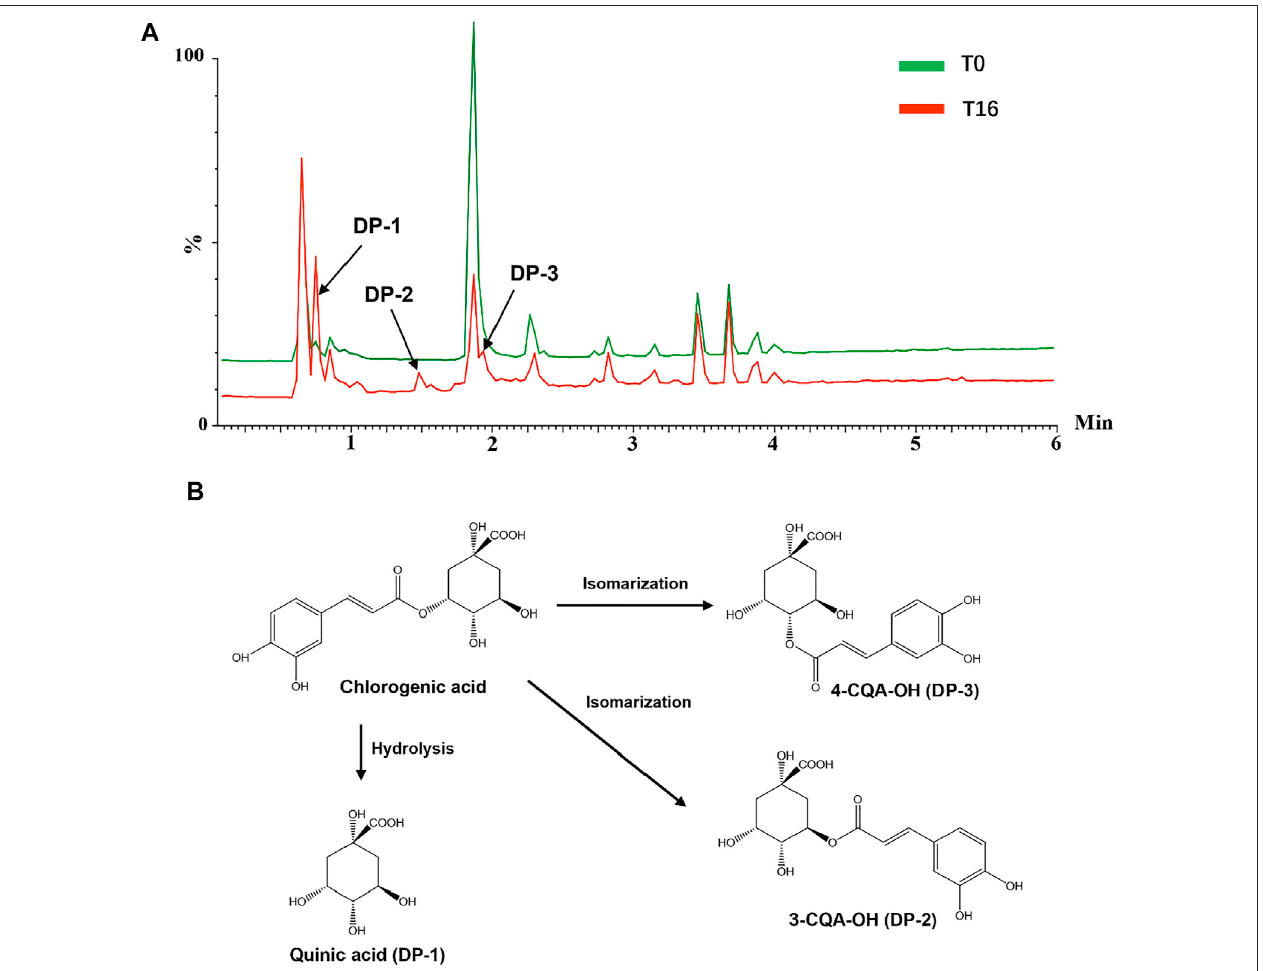
FIGURE 6 | (A) TIC of chlorogenic acid dissolved in base liquor before (T 0 ) and after 16 weeks (T 16 ) in temperature-accelerated tests. (B) Proposed degradation mechanism of chlorogenic acid in base liquor under high-temperature exposure.